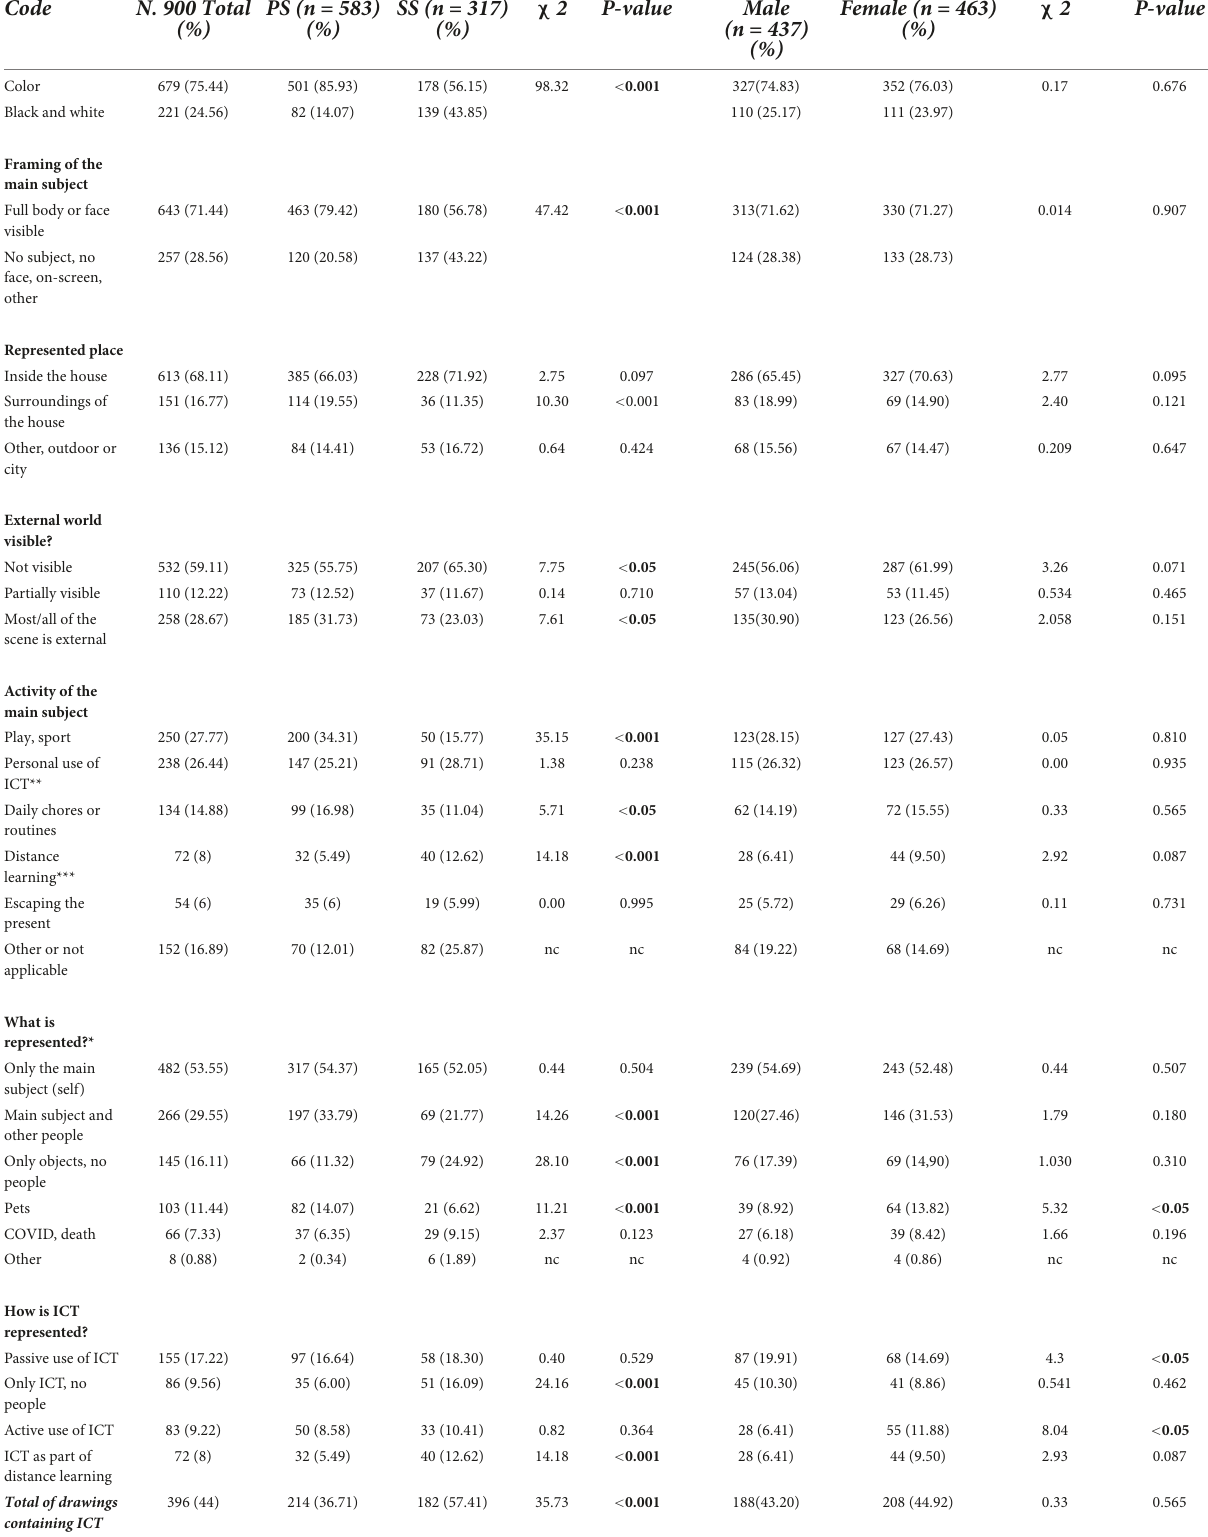
TABLE 2 Quantitative content analysis of the drawings for school level and